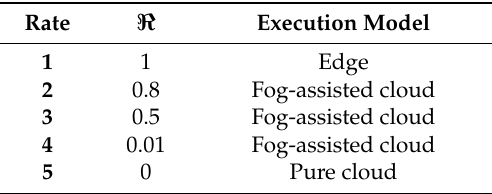
Figure 6. ( a ) Variation of mean transmission latency against Fog Network Efficiency (FNE). ( b ) Variation of mean processing latency against FNE. ( c ) Variation of mean service latency against FNE. Table 2. Change in execution strategy with varying FNE.